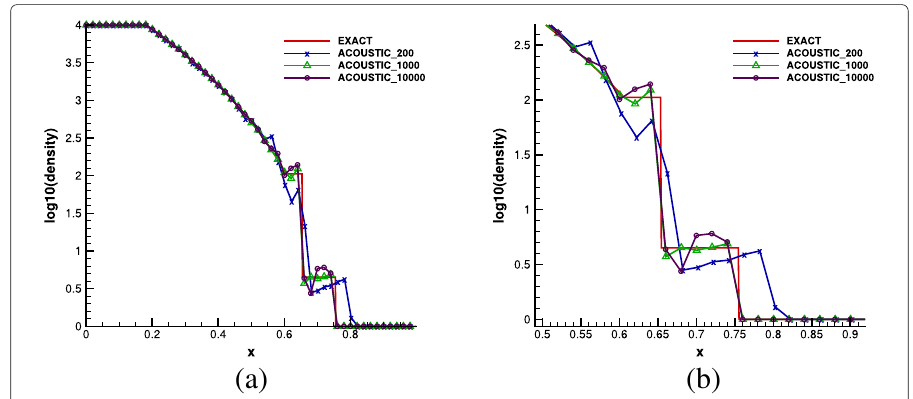
Fig. 1 The numerical solutions computed by the second order acoustic GRP scheme (with the exact Riemann solver) are compared with the exact solution (only 66 cells are shown) a Acoustic GRP solver with different grid points. b Zoomed